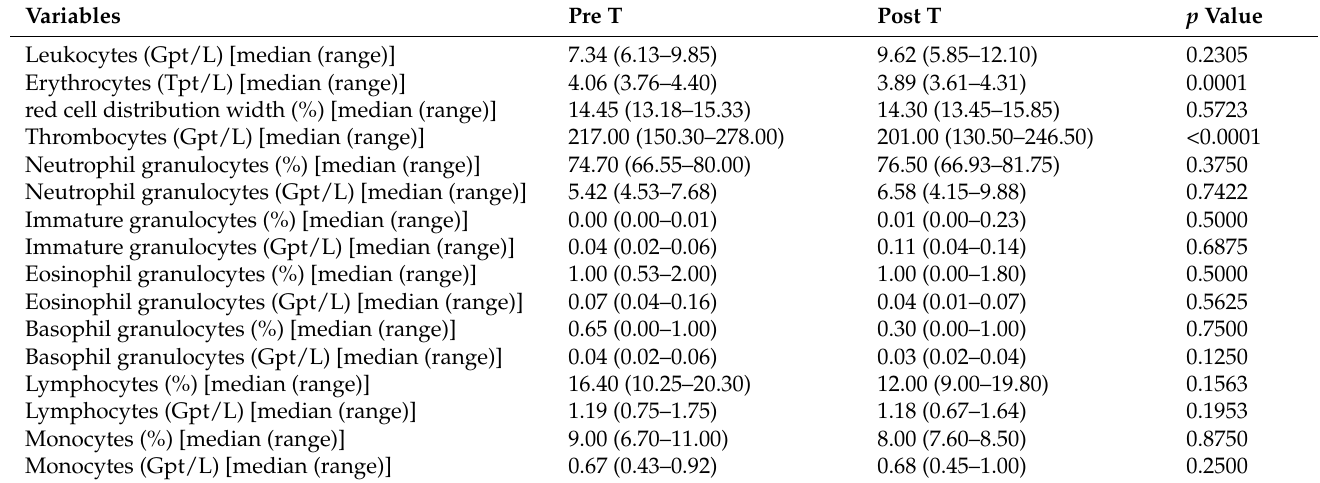
Table 2. Complete blood counts one day before (pre T) and two days (post T) after selective inter- nal radiotherapy radioembolization. Median value with 75% percentile is given. Nonparametric Wilcoxon matched-pairs signed rank test was performed and a p value below 0.05 was considered statistically